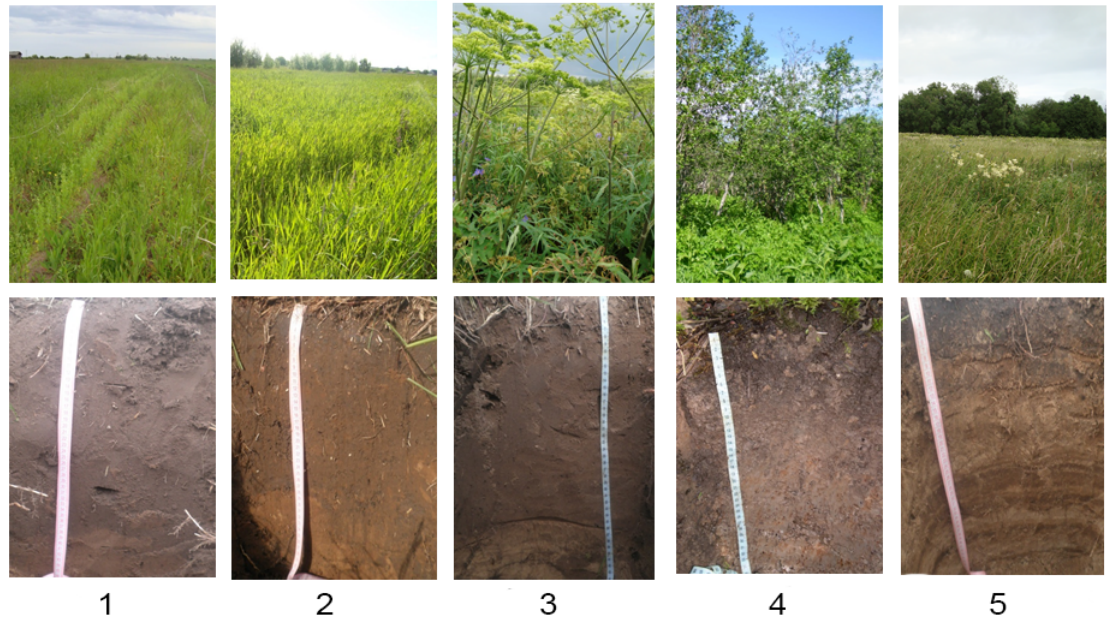
Fig. 3 Vegetation and typical profiles of alluvial soils in the Northern Dvina delta floodplain in fallow lands of different ages: at 5 years (1), 6–19 years (2), 20–40 years (3), over 50 years (4), and in natural lands